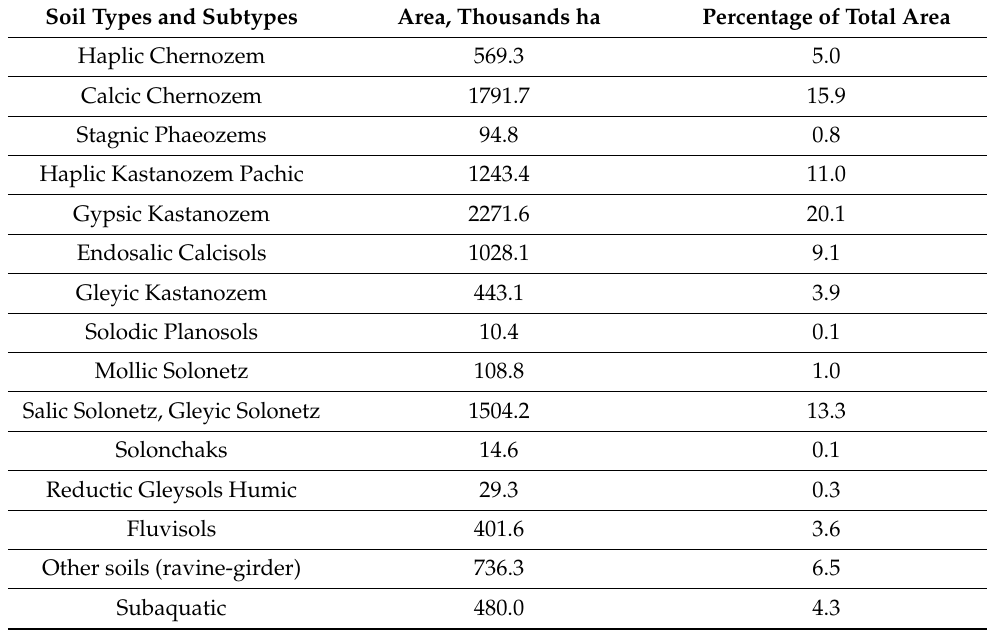
Table 5. Structure of the soil cover of the Volgograd region.